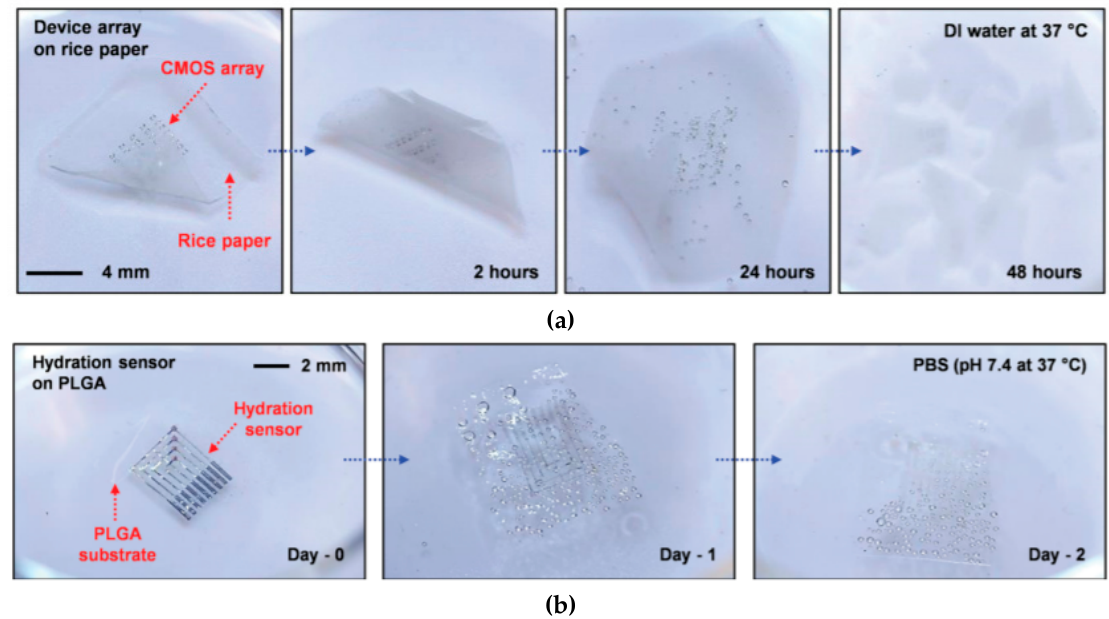
Figure 9. Optical images at various stages of dissolution of ( a ) an array of transient CMOS inverters on rice paper upon immersion in DI water at 37 °C and ( b ) of a hydration sensor on a PLGA film in PBS. Reproduced from [64] with permission. Copyright © 2014 Wiley and Sons.